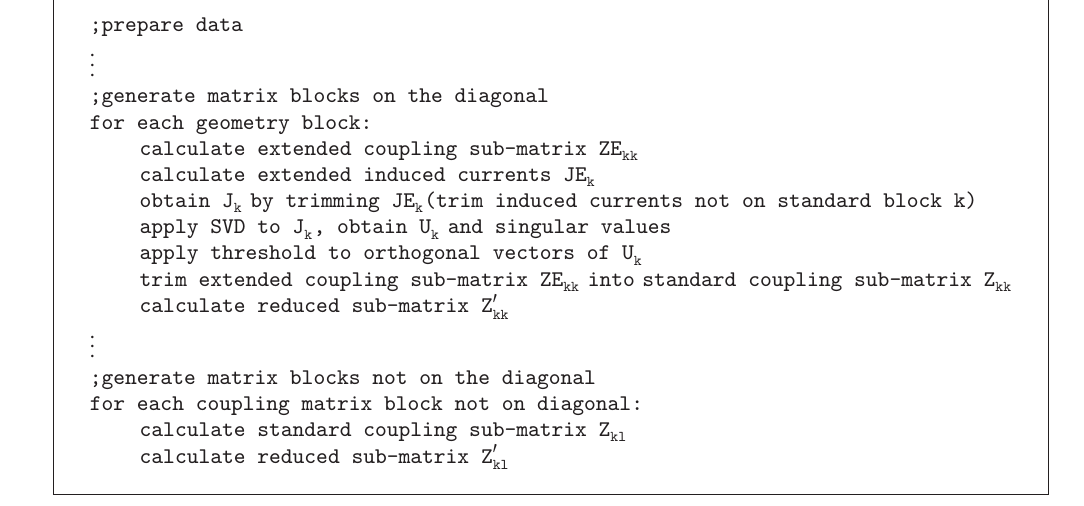
Algorithm 1: Pseudocode for the